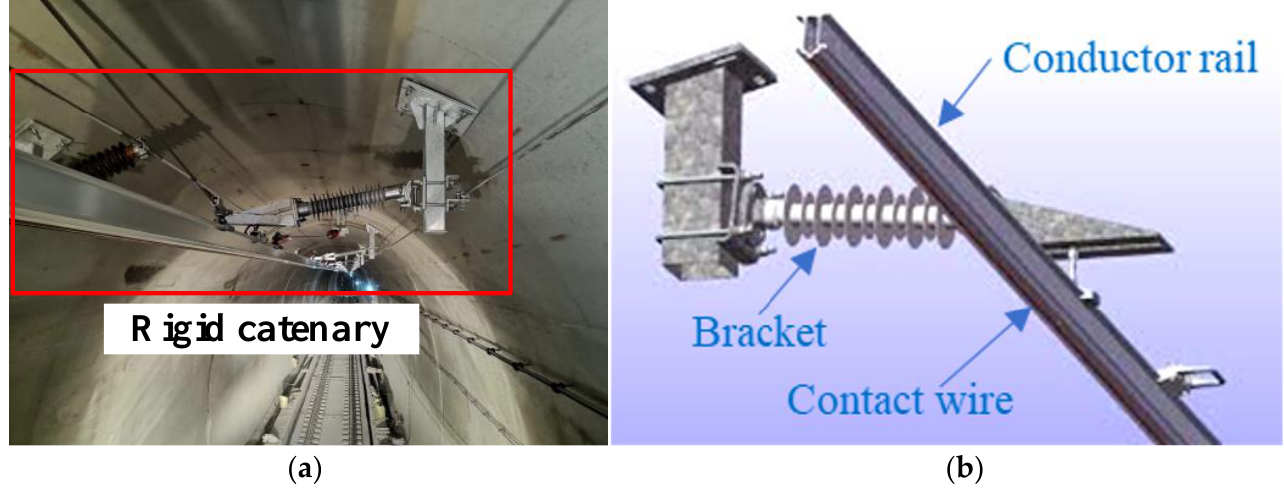
Figure 1. Schematics of a rigid catenary system. ( a ) presents an overall rigid catenary; ( b ) illustrates the main components of a rigid catenary system.